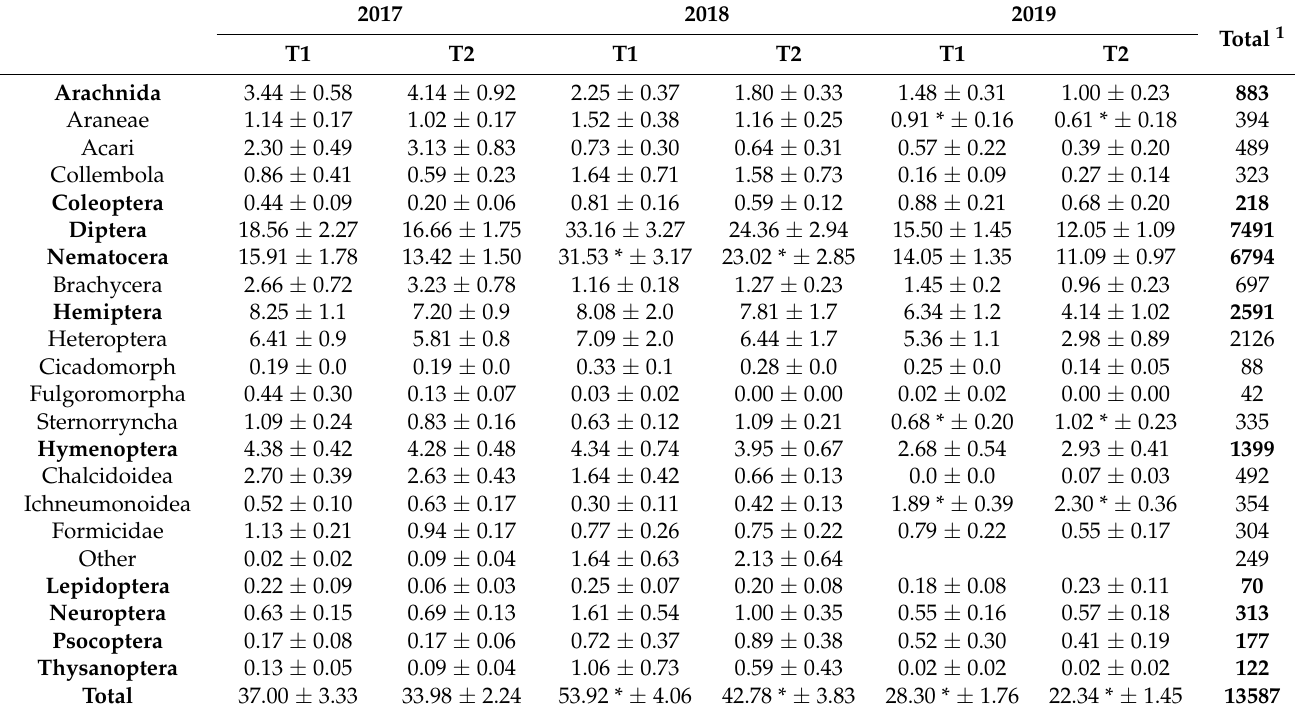
Table 2. Average per day and repetition ( ± SE) of the arthropods recuperated using the vacuum sampling method for the three years of study. Both treatments T1 and T2 had four plots (repetitions)